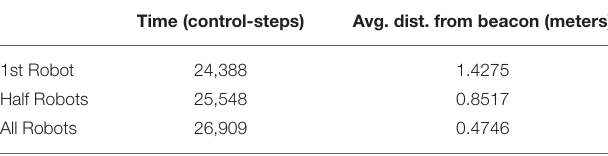
TABLE 3 | Normally functioning swarm performance of collective photo-taxis. Time